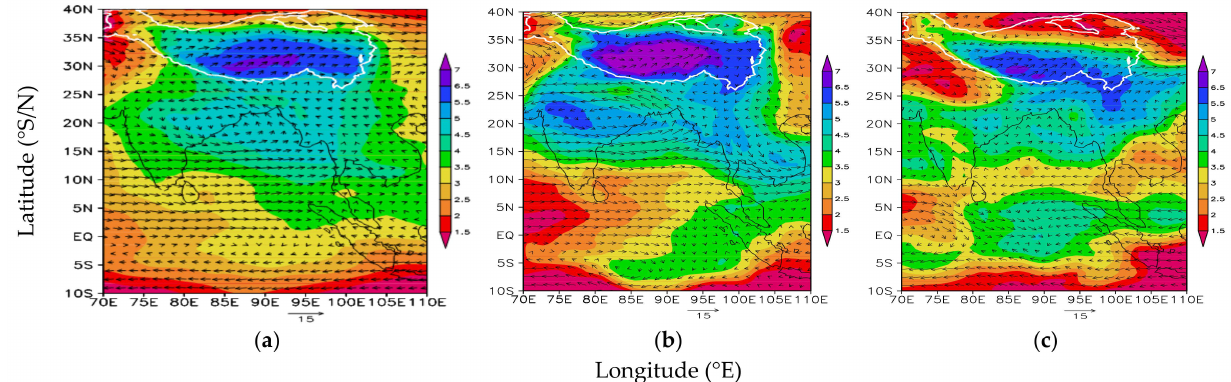
Figure 4. Horizontal distributions of wind (arrows, units: m/s) and specific humidity. (shadings, units: g/kg) at 500 hPa averaged for ( a ) the observation period, ( b ) the SASM active period, and ( c ) the SASM break